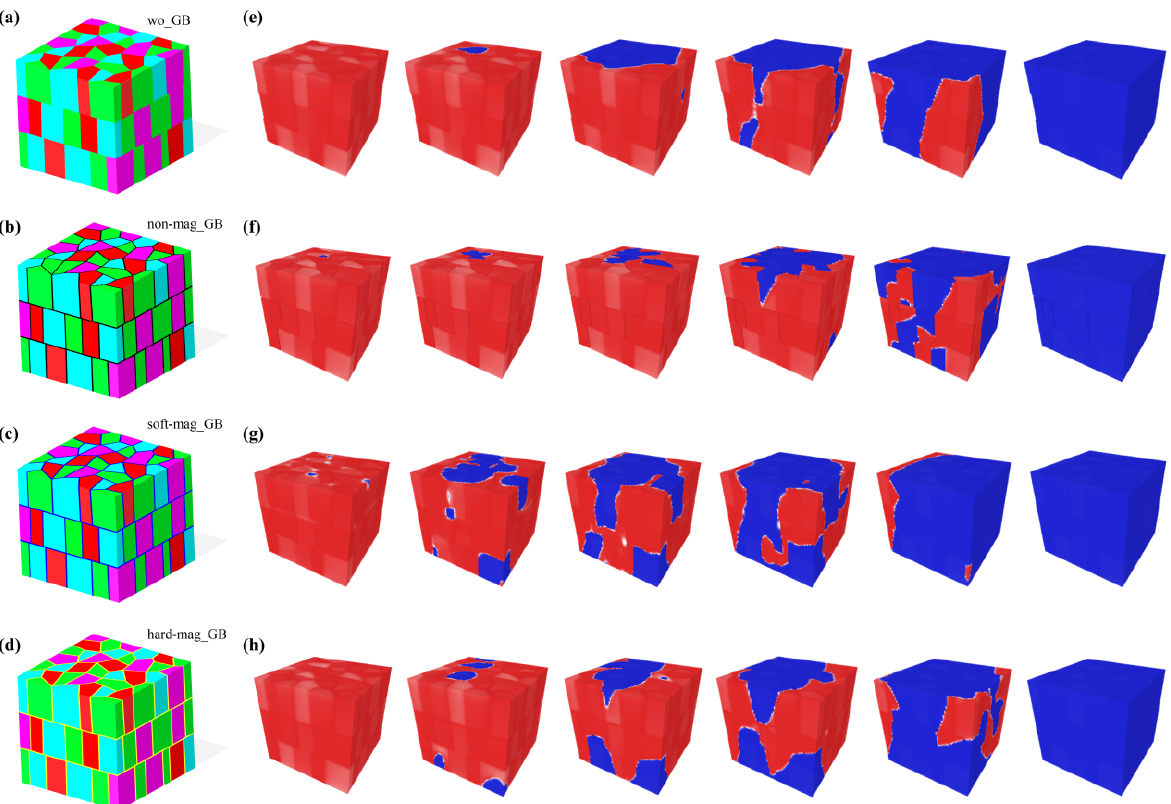
Figure 4. Evolution of 3D domain structures during magnetization reversal. Three-dimensional microstructures of models with different types of GBs: ( a ) without GB, ( b ) nonmagnetic GB, ( c ) soft- magnetic GB, and ( d ) hard-magnetic GB. ( e – h ) Three-dimensional domain structures of models corresponding to the microstructures in ( a – d ) during the propagation of reversed domains. All these dynamic processes were gathered around the coercivity of each microstructural model.